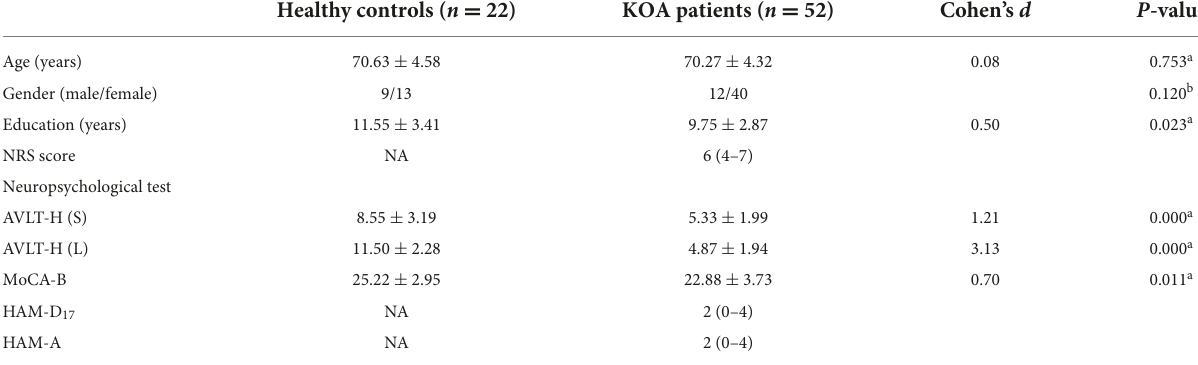
TABLE 1 Demographic and neuropsychological test.